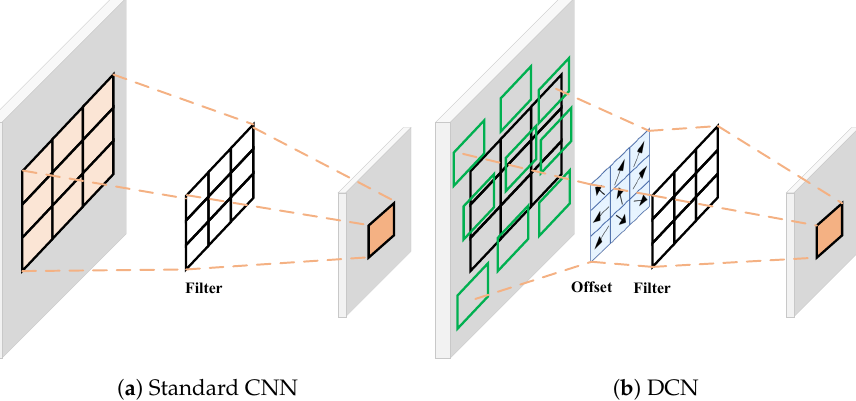
Figure 3. Illustration of standard CNN in ( a ) and DCN in ( b ). DCN utilizes an additional offset learned from the feature map to obtain a wider receptive field compared with